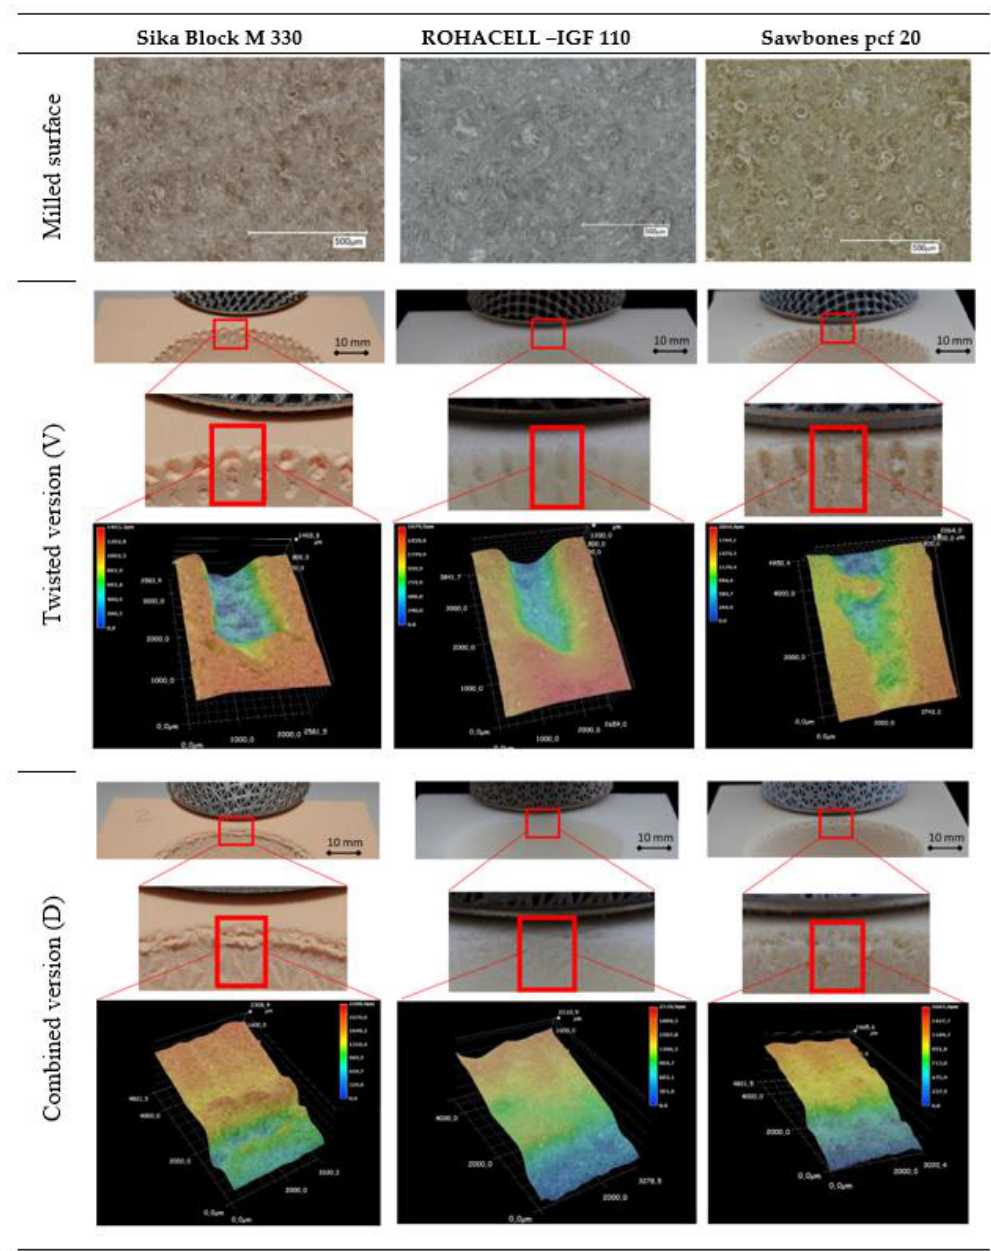
Figure 3. Representative images of the various artificial bone cavity materials after cup seat creation using machine milling and of the twisted structure and the combined structure after the testing to determine fixation strength.